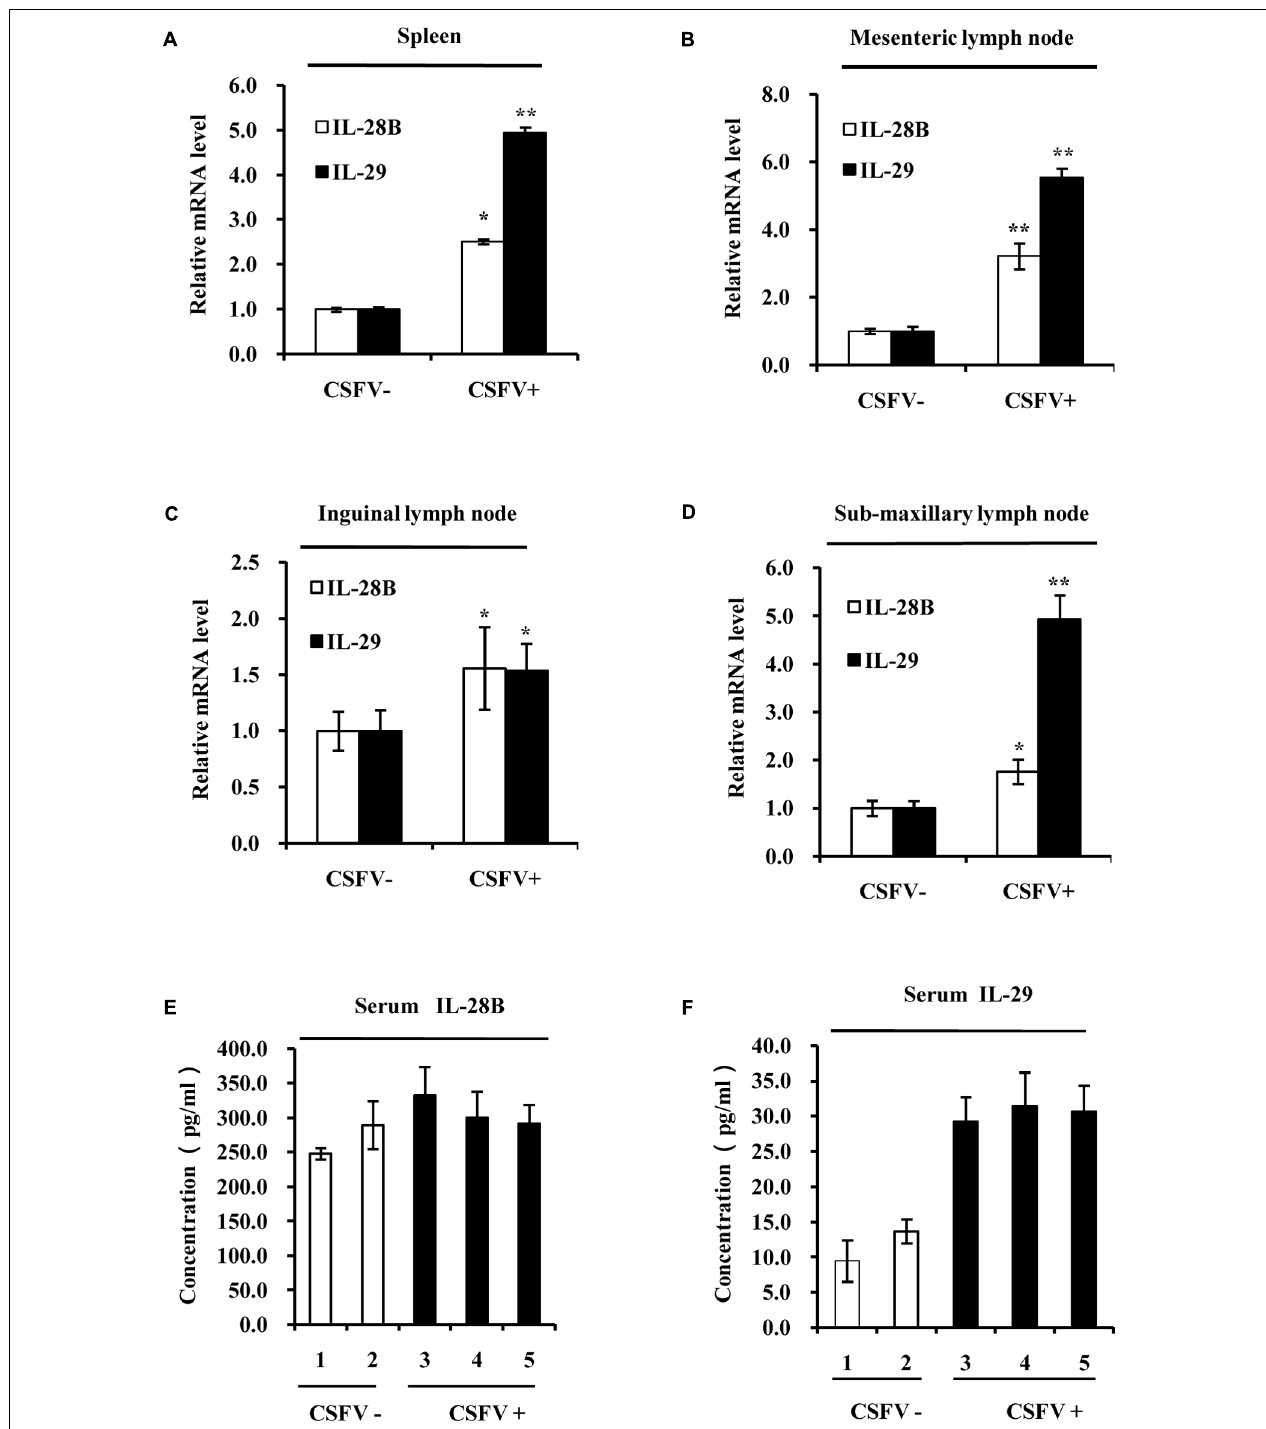
FIGURE 2 | Classical swine fever virus infection increases the expression of type III IFNs in the lymphoid tissues of pigs. Quantitative real-time PCR was performed to examine the mRNA levels of IL-28B and IL-29 in (A) spleen, (B) mesenteric lymph node, (C) inguinal lymph node, and (D) sub-maxillary node of pigs infected with CSFV for 5 days and mock treated control pigs. The results are representative of three independent experiments. ∗ P < 0.05, ∗∗ P < 0.01. (E,F) Protein levels of IL-28B and IL-29 in the serum of pigs infected with or without CSFV for 5 days were analyzed by ELISA using indicated antibodies. The pigs of numbers 1 and 2 are mock treated controls, and the pigs of numbers 3, 4, and 5 are infected animals by CSFV for 5 days (These are same for other figures). Plotted are the average results from three independent ELISA experiments with similar results.